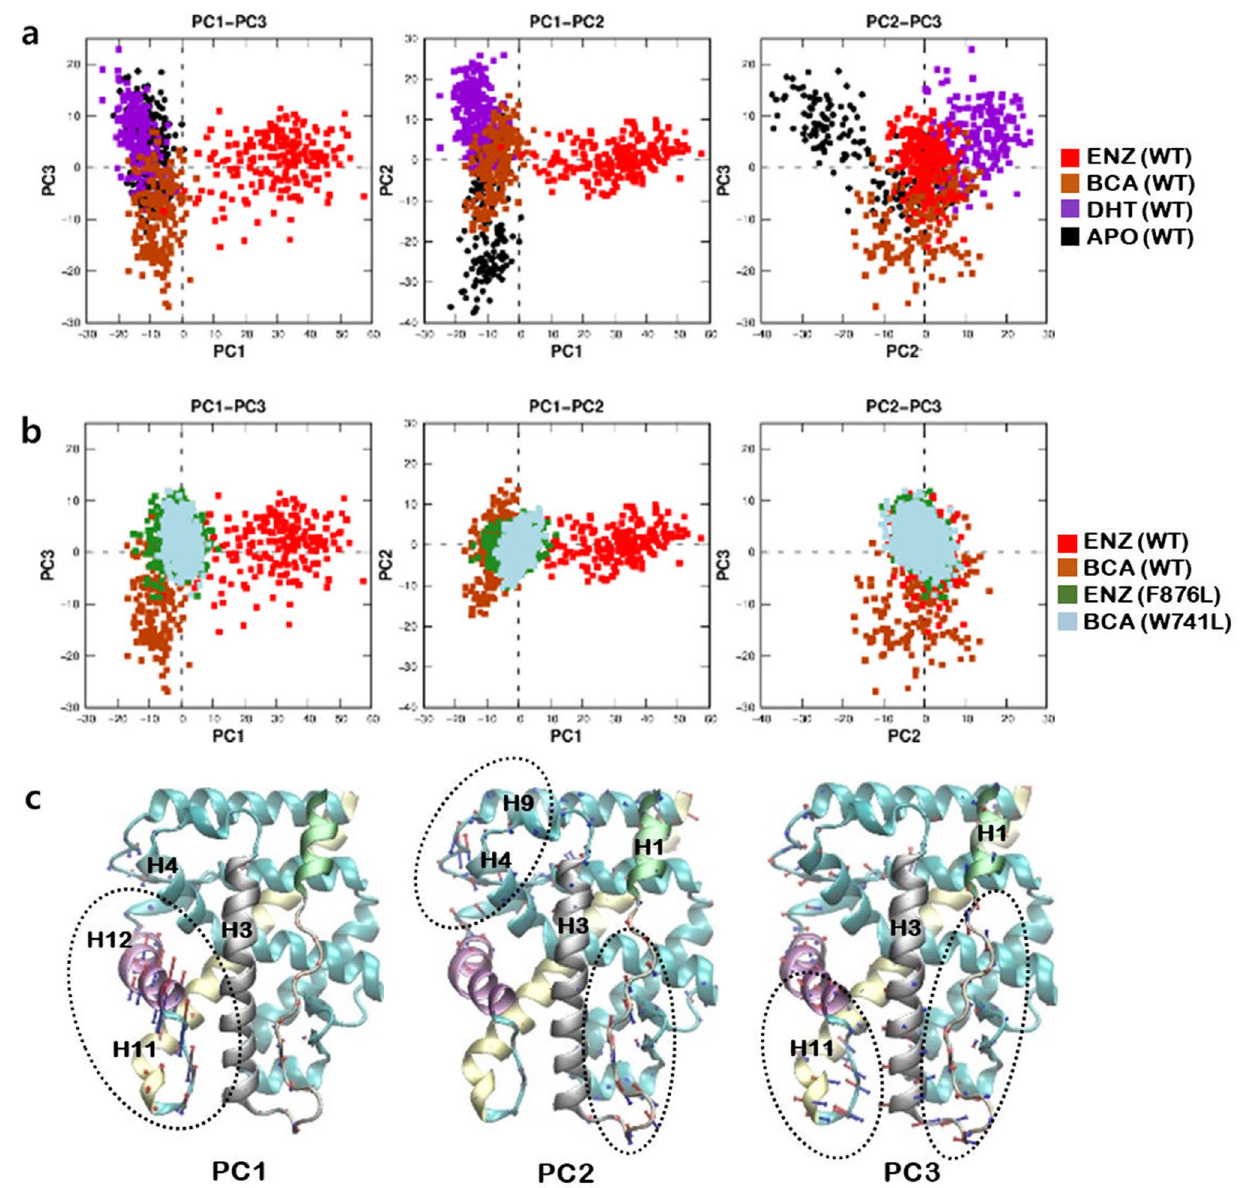
of AR bound with ENZ in conformation 2 (red), BCA (brown), DHT (purple) and no ligand ( apo , black). ( b ) Projections of aMD trajectories of the wild type ARs bound to ENZ in conformation 2 (red), BCA (brown), F876L mutant AR bound to ENZ in conformation 2 (green) and W741L mutant AR bound to BCA (cyan) ( c ) Visualizations of the three PCs. Arrows show the direction and relative magnitude of Cα motions along the corresponding PC. Colors of arrows represent the positive (blue) and the negative (red) directions along each PC eigenvector. Images were created by using Gnuplot v5.2 57 and VMD v1.9.3 52